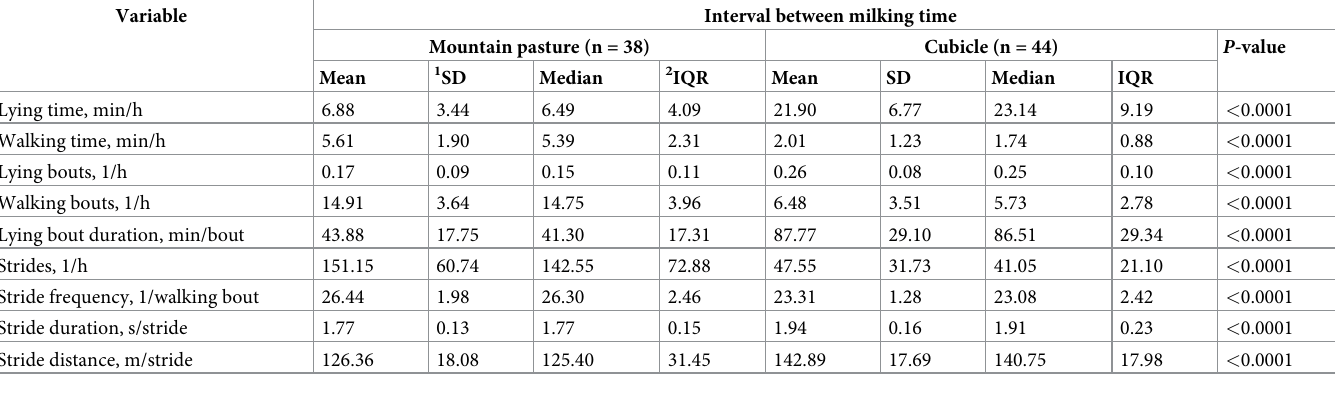
Table 4. Comparison of RumiWatch 1 accelerometer variables of mountain pasture and cubicle housing cows during the interval between milking times. Variable Interval between milking time Mountain pasture (n =